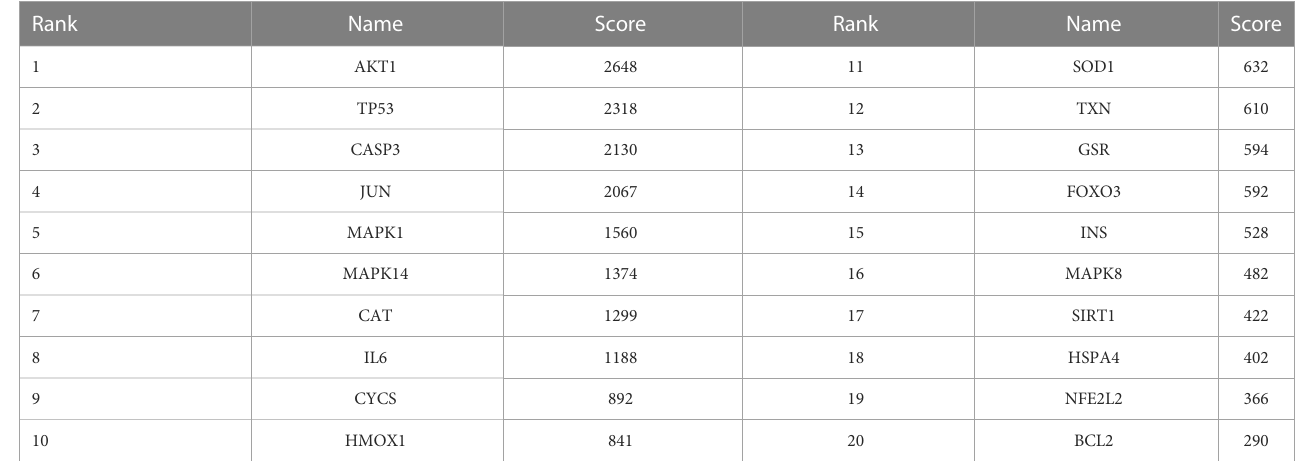
TABLE 2 Top 20 genes, as determined by the MCC method.